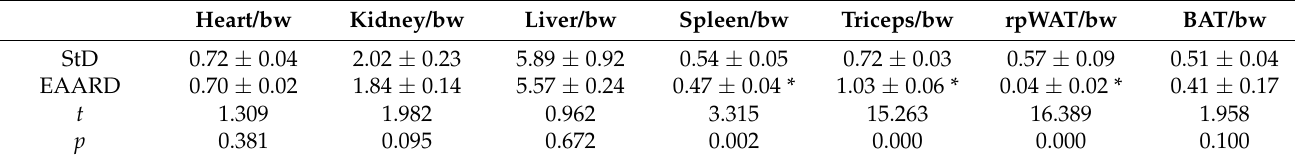
Table 4. Organ weight normalized to b.w. (mean ± sd) at the end of treatment.